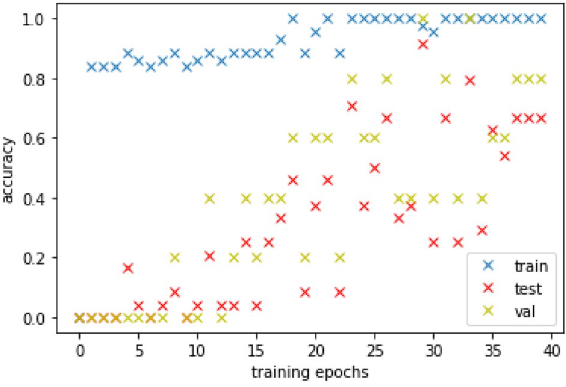
Figure 6. First 40 ANN training epochs on one subject.